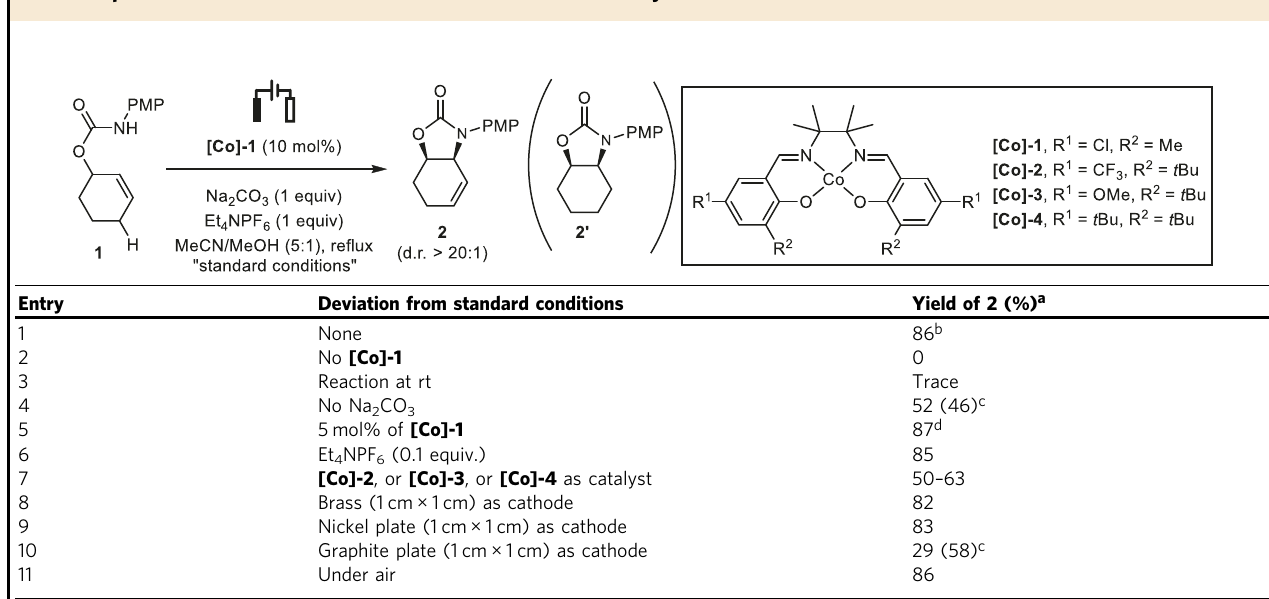
Table 1 Optimization of reaction conditions for intramolecular allylic C – H